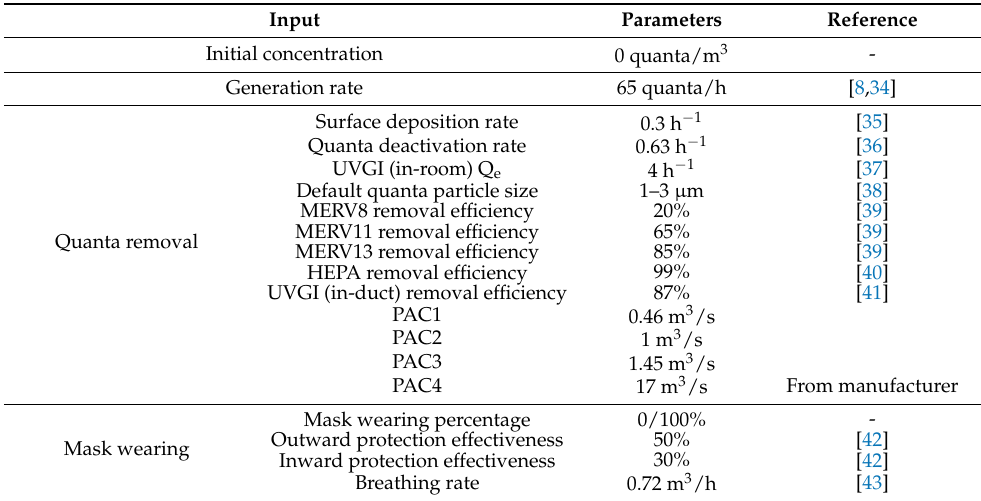
Figure 5. Medium Office ( a ) top-view diagram showing outdoor air flows (blue) and exhaust/return flows (gray) and ( b ) quanta concentration as a function of time during a workday with the infector in the core zone on the first floor. Contaminant generation source and deposition/deactivation items were added on the top-left of each room (small symbols).